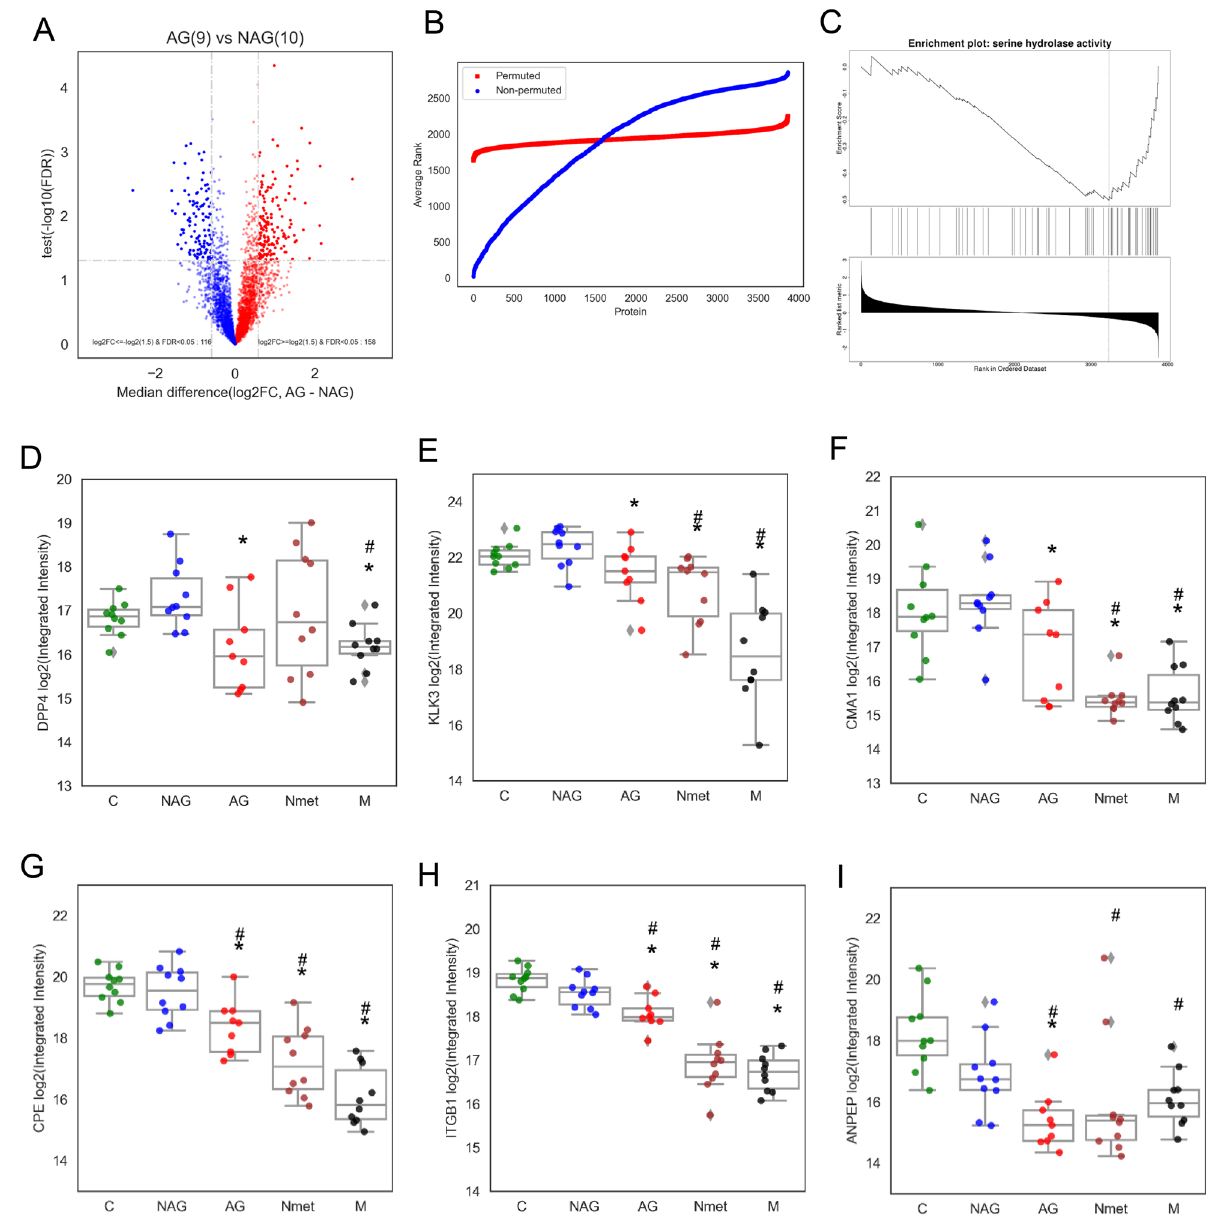
Figure 3. Functional analysis of different subtypes of PCa. ( A ) Volcano plot of differentially expressed proteins between NAG and AG groups. ( B ) Permutation test for the selection of stable proteins discriminating between NAG and AG groups. ( C ) Functional enrichment of proteinases suggested by GSEA analysis via WebGestalt. ( D ) Expression patterns of DPP4, ( E ) Expression patterns of KLK3, (F) Expression patterns of CMA1, ( G ) Expression patterns of CPE, ( H ) Expression patterns of ITGB1, and ( I ) Expression patterns of ANPEP in different tumor subtypes. * P < 0.05 (NAG vs other subtypes). #: P < 0.05 (C vs other